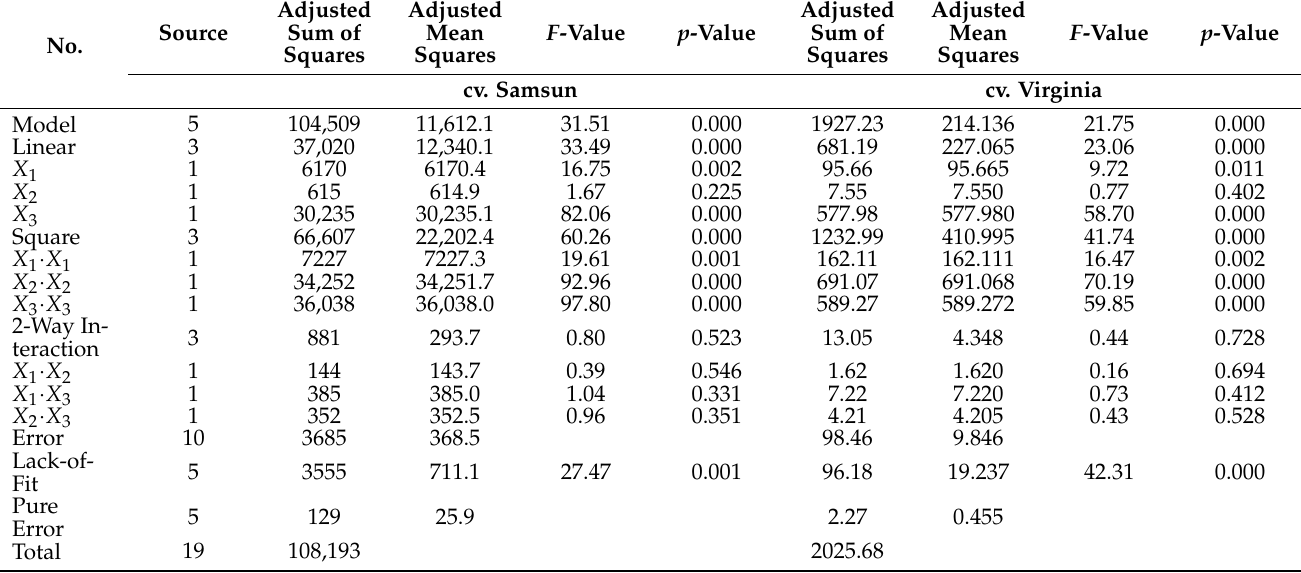
Table 8. The ANOVA for the response surface square model for the N. tabacum cv. Samsun and N. tabacum cv. Virginia leaves’ nicotine relative